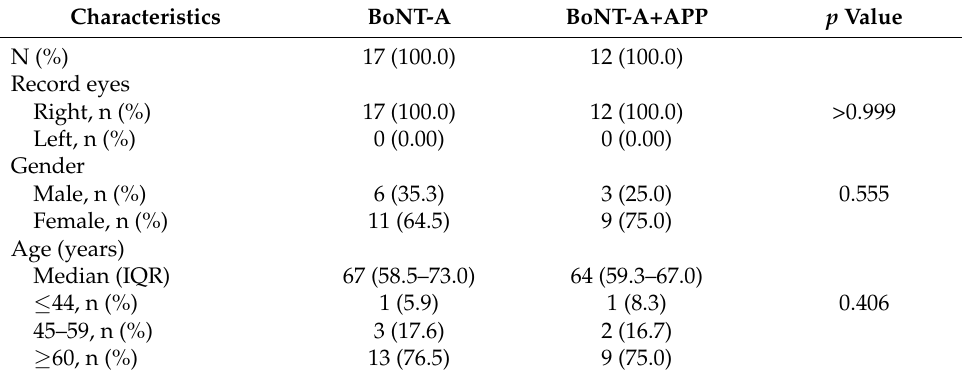
Table 1. Demographic characteristics of the blepharospasm patients with dry eye.